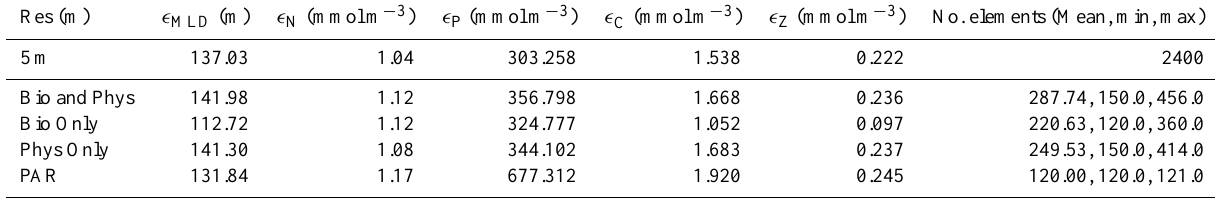
Table 7. The rms error, (cid:15) , of adaptive mesh simulations compared to the simulation with 2.5m vertical resolution at Station India. (cid:15) is shown for MLD, and the L2 norm of nutrient, primary productivity, chlorophyll and zooplankton. See Fig. 8 also. Res